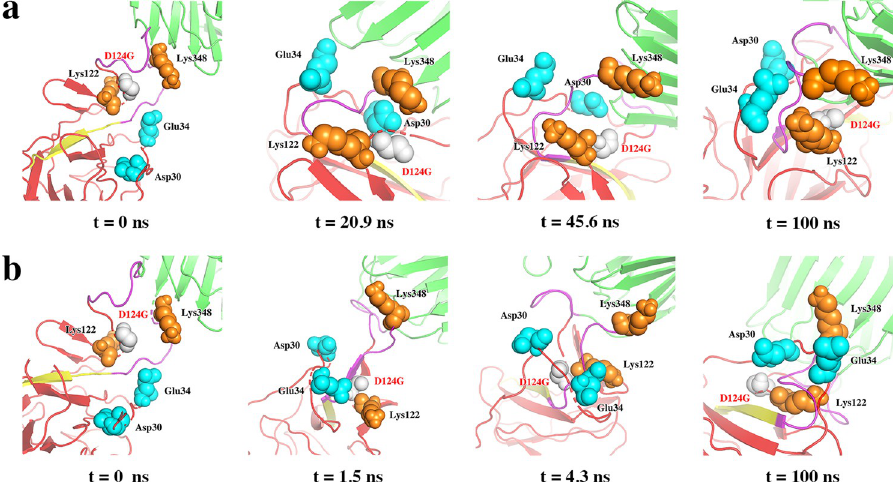
Fig 6. Structure in simulated trajectory of D124G. (a) and (b) are two similar simulation results. Lys348, Asp30, Glu34, Lys122 were connected to each other through electrostic interactions, and all four members maintained a balanced network